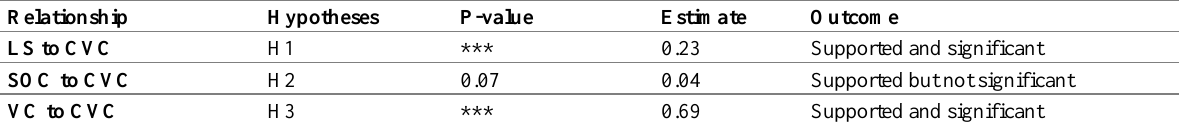
Table 8: Hypotheses